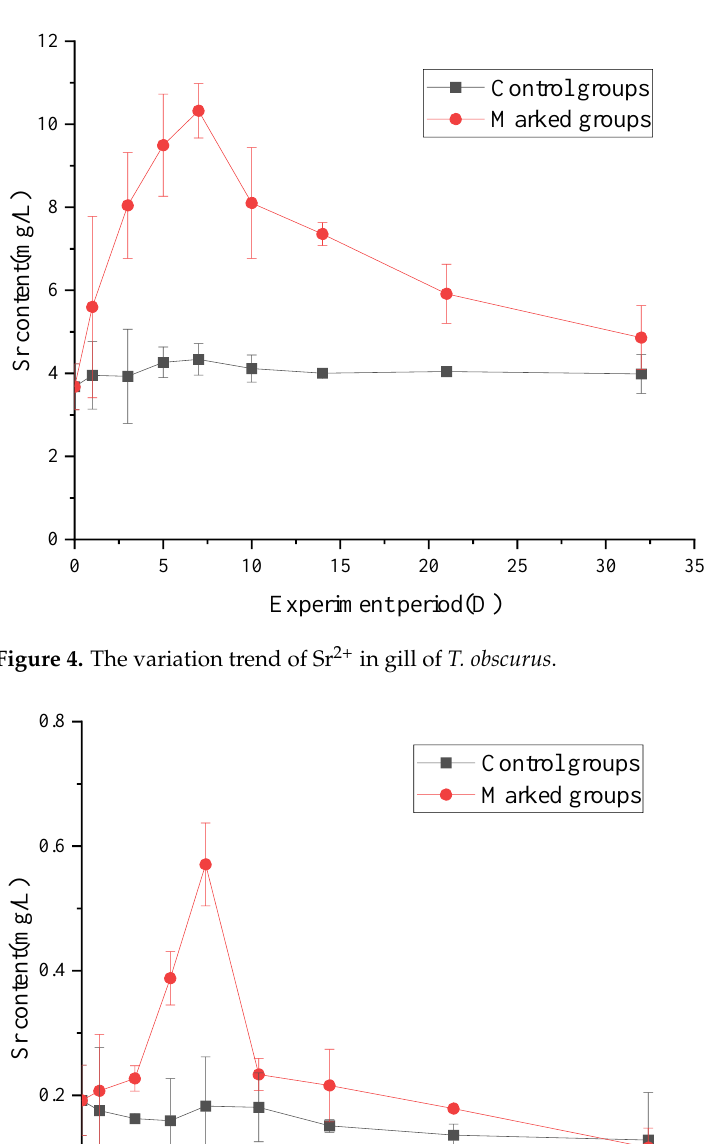
Figure 5. The variation trend of Sr 2+ in liver of T. obscurus .